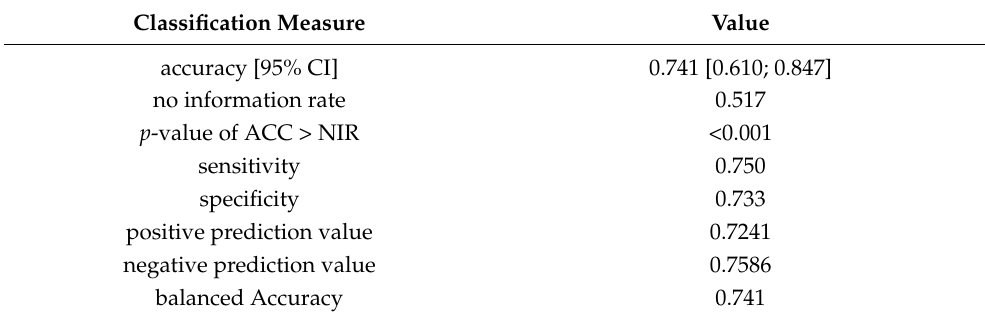
Table 4. Classification accuracy of ADHD and TDC based on odor perception.